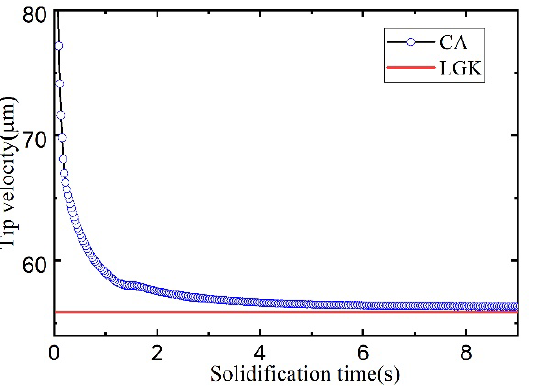
∆ T = . Figure 5. Comparison of the steady tip velocity at a constant undercooling ∆𝜕𝜕 = 8 𝛤𝛤